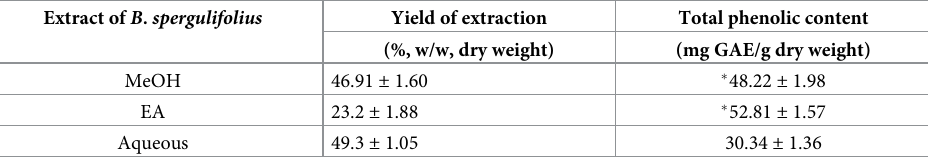
Table 3. Yield of extraction (%) and TPCs of Bolanthus spergulifolius extracts from different solvents. Extract of B .